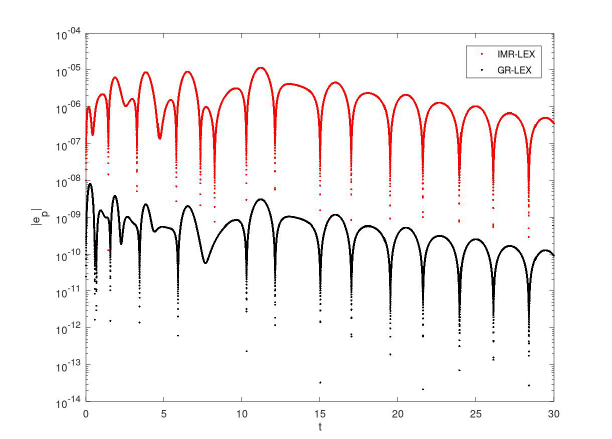
Figure 5. Errors of GR-LEX (black) and errors of IMR-LEX (red) for generic initial conditions x 0 = 2.16, p 0 =